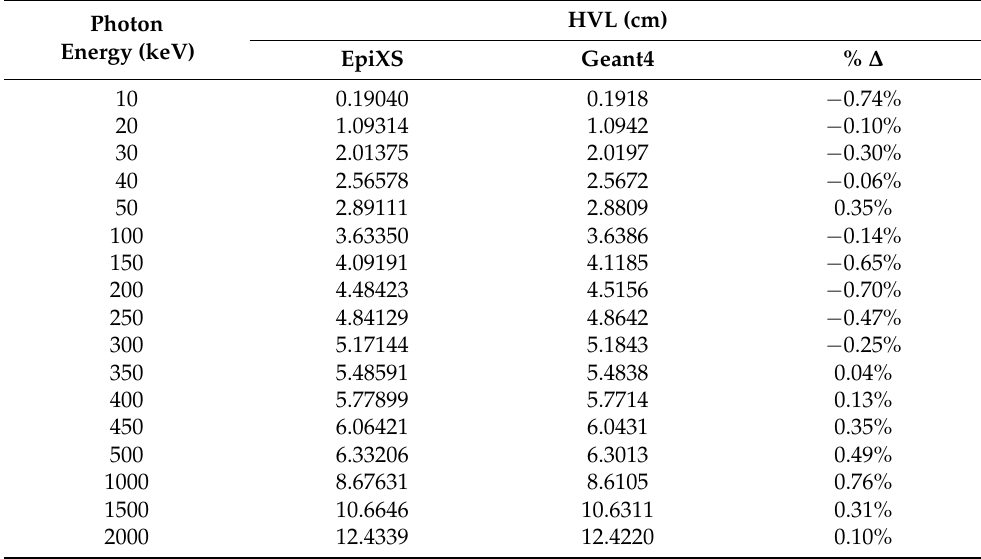
Table 1. Half value layers of the investigated Polyimide as found by EpiXS and Geant4.